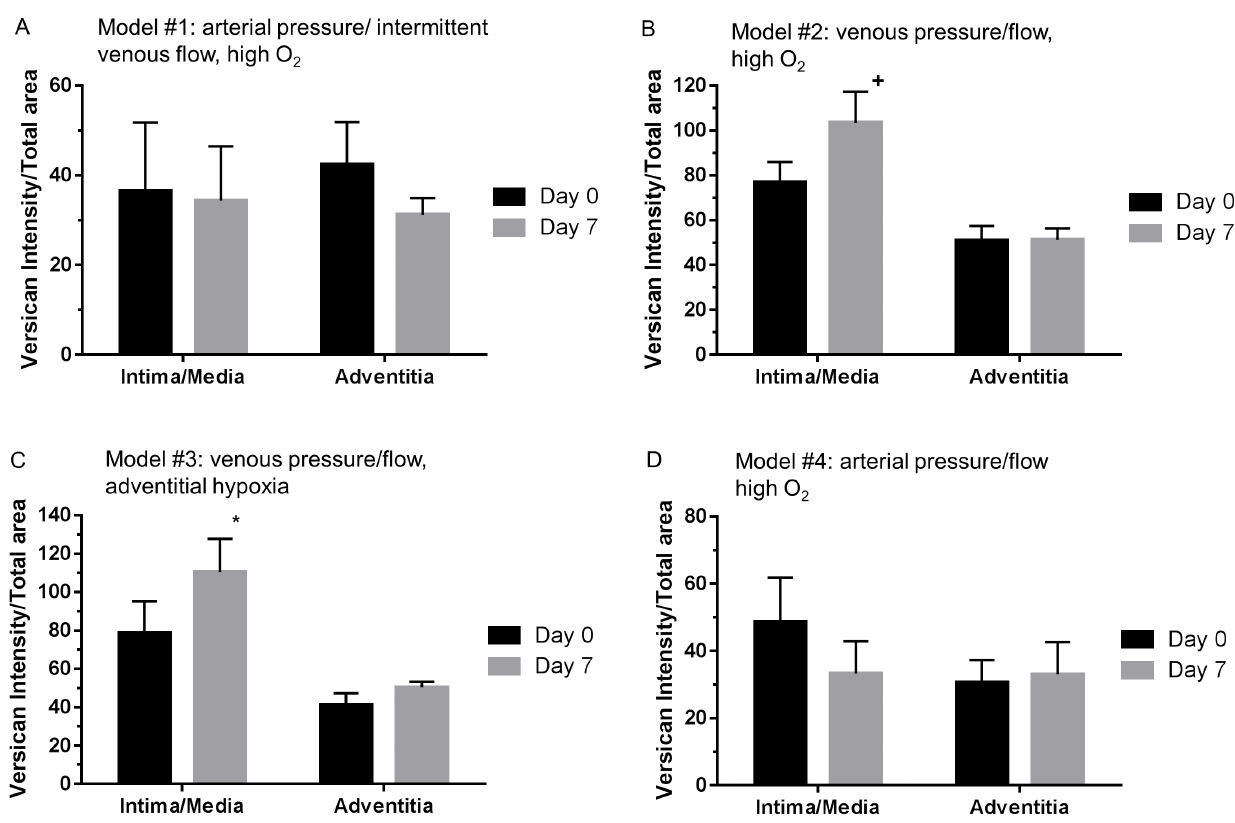
Fig 8. Versican expression levels in pre-culture and 7 day ex-vivo perfused veins. (A) Model #1: arterial pressure/ intermittent venous flow, high O 2 . (B) Model #2: venous pressure/flow, high O 2 . (C) Model #3: venous pressure/flow, adventitial hypoxia (D) Model #4: arterial pressure/flow high O 2 . (cid:3) P < 0.05 vs day 0, + P < 0.07 vs day 0 (black bars are day 0 and gray bars are day 7). N = 4 veins for models 1 and 4 and N = 5 veins for models 2–3.